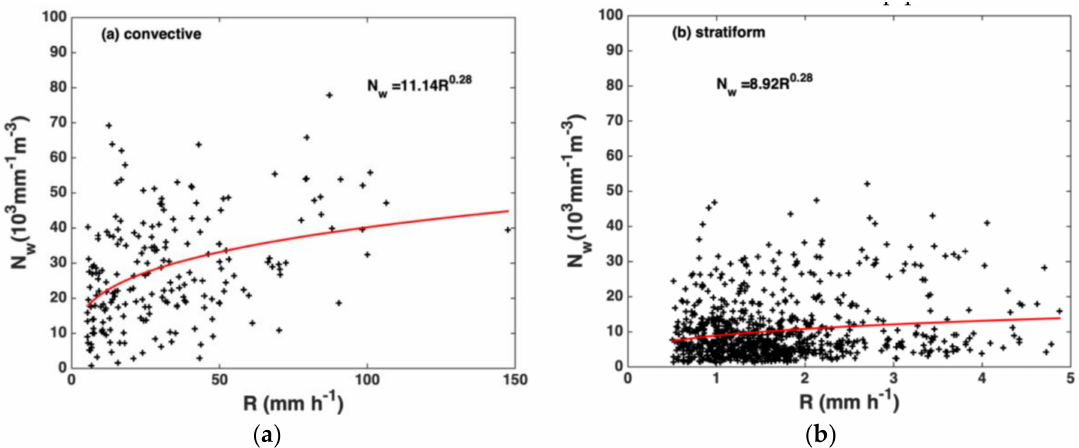
Figure 4. Scatter plots of N w vs. R for ( a ) convective and ( b ) stratiform rain types. The fitted power law relationships using a least-squares method are also provided in each